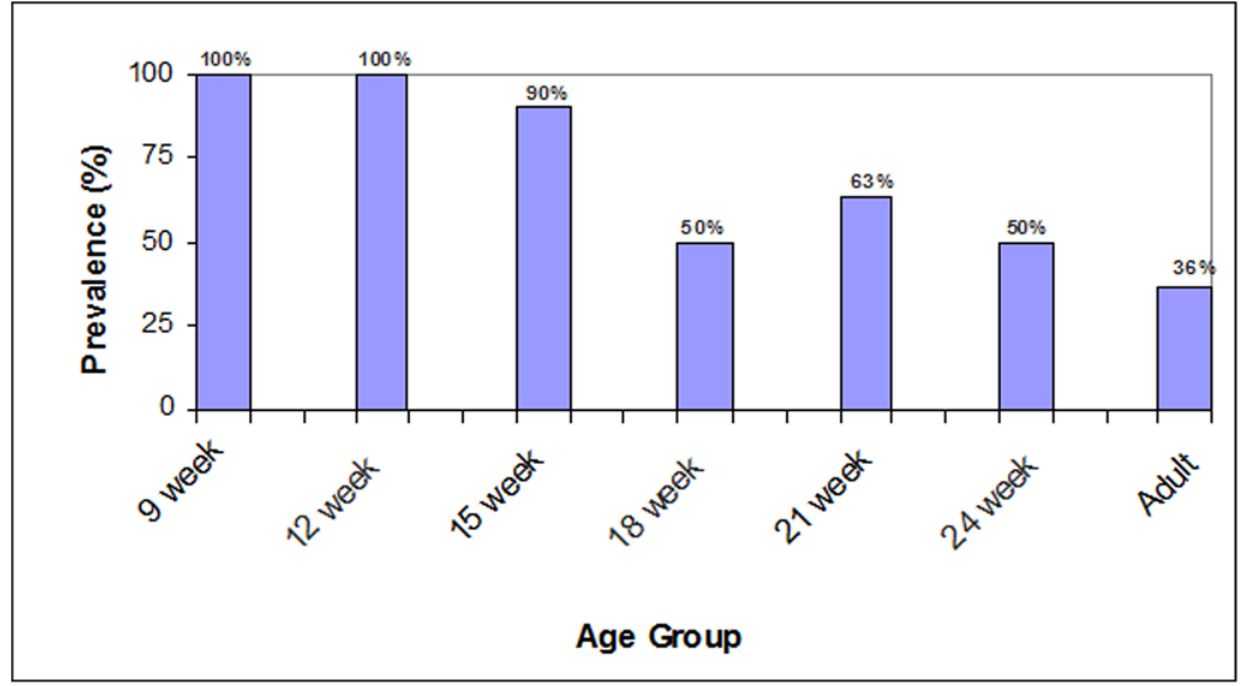
Figure 1. Prevalence of MRSA in swine from production system A by age aroup.